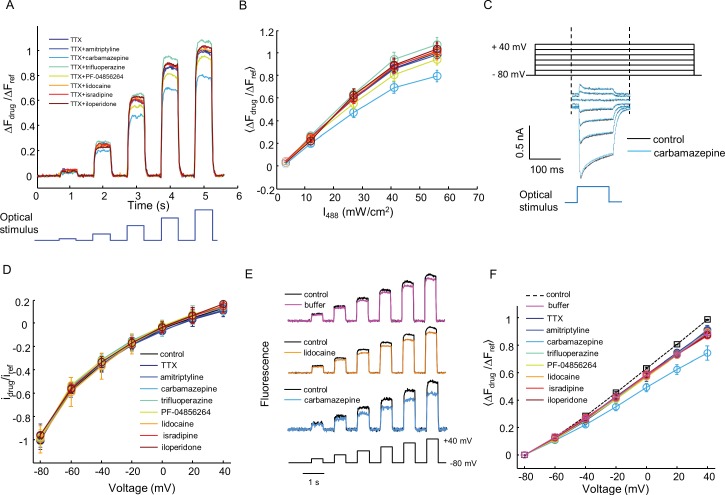
Characterization of off-target effects via optical and manual patch assays.(A) Optical assay to detect perturbations to Kir2.1, CheRiff, or QuasAr2 in NaV1.7-OS HEK cells. NaV1.7 was blocked with 1 μM TTX. Cells were stimulated with increasing intensities of blue light (500 ms, 3.2, 12, 27, 41, 56 mW/cm2), and QuasAr2 fluorescence was monitored with 635 nm excitation, 400 W/cm2. Fluorescence with a test compound (10 μM amitriptyline, 100 μM carbamazepine, 10 μM trifluoperazine, 1 μM PF-04856264, 200 μM lidocaine, 10 μM isradipine, 10 μM iloperidone) was compared to TTX alone. The fluorescence changes were normalized to that of TTX only treated cells under 56 mW/cm2 stimulation. (B) Mean fluorescence changes in (A) during the blue stimuli as a function of stimulus intensity. Error bars represent s.e.m. of n = 9–10 wells. (C) Voltage clamp protocol to test for drug effects on CheRiff photocurrent. Cells were held at −80 mV and then stepped to −60 mV to +40 mV in 20 mV increments. During each step depolarization, a blue light pulse (100 ms, 0.5 W/cm2) was applied to activate CheRiff current. Control trace and trace after carbamazepine treatment are shown as an example. (D) I-V relationship of CheRiff current under control condition (before drug treatment) and with test compounds at the same concentrations as in (A). To control for cell-to-cell variations in CheRiff expression, the current amplitudes were normalized to that of control at −80 mV. Error bars represent s.e.m., n = 29 cells for control, n = 3–4 cells for each compound. (E) Voltage-clamp measurements to test for drug effects on QuasAr2 voltage sensitivity. QuasAr2 fluorescence was monitored with 640 nm excitation, 400 W/cm2 while membrane voltage was modulated as shown. Single cell recordings were performed before and after addition of drug or buffer control. Example traces show fluorescence before and after addition of buffer, lidocaine or carbamazepine. (F) Mean QuasAr2 fluorescence as a function of voltage in the presence of test compounds at the same concentrations as in (A). To control for cell-to-cell variation in QuasAr2 expression, the fluorescence changes were normalized to the pre-drug fluorescence at +40 mV. Error bars represent s.e.m., n = 30 cells for control, n = 3–4 cells for each compound.